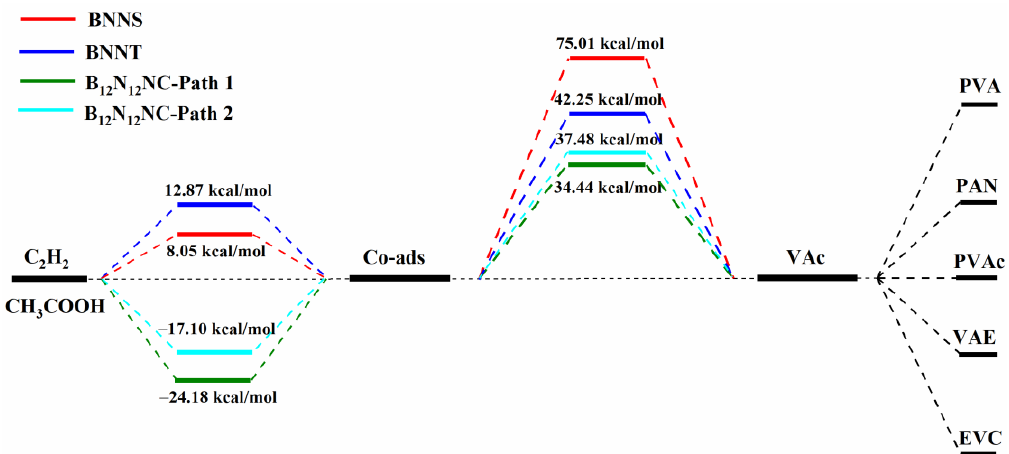
Figure 1. Energy change of acetylene acetic acid reaction catalyzed by BN catalysts with different geometric structures at 1 atm and 493.15 K.